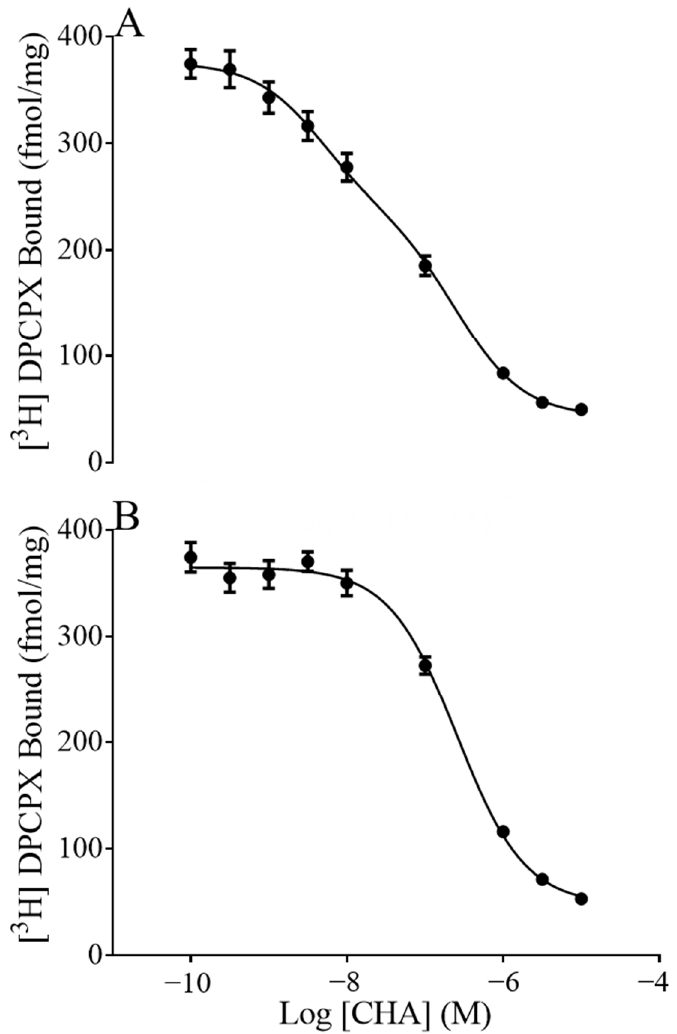
Figure 2. [ 3 H] DPCPX displaced with CHA in the presence or absence of GTP. Summer forebrain binding curves were best fit by a two-site model in the absence of 1 µ M GTP ( A ) and one-site in the presence of 1 µ M GTP ( B ). The general characteristics of these graphs were conserved in the winter season of the forebrain as well as the hippocampus and hypothalamus (not shown).